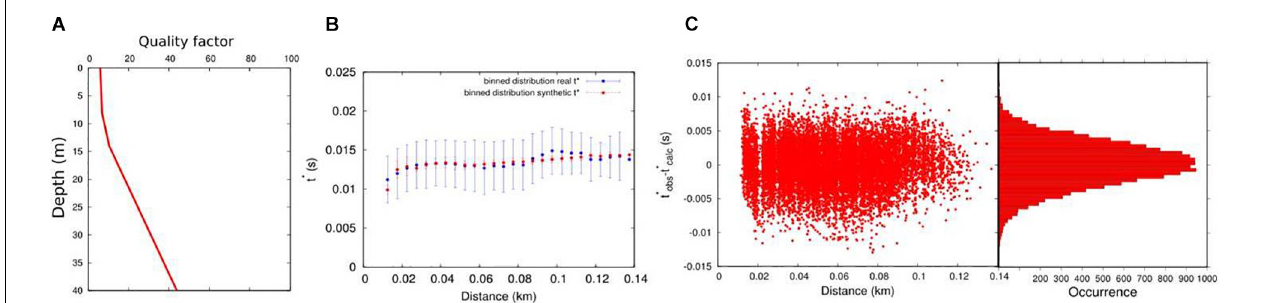
FIGURE 5 | (A) Final 1-D attenuation model retrieved at the end of grid-search procedure. (B) Real and synthetic t ∗ distribution. The blue points represent the binned distribution of measured t ∗ . The red points represent the binned distribution of synthetic ∗ , relative to the represented 1-D Q P and 3-D V P models. (C) Representation of residuals between observed and synthetic t ∗ as a function of distance. The right figure represents the histogram of residuals.